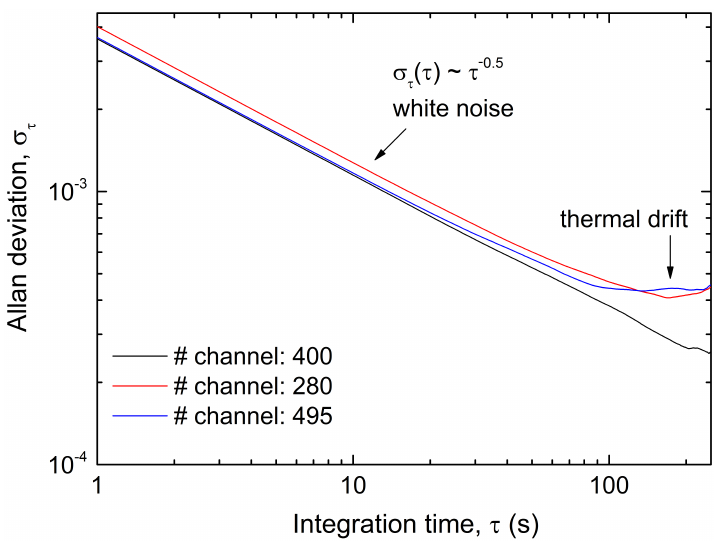
Figure 5. Allan-deviation plots derived from three different channels of the sample gas measurement in Figure